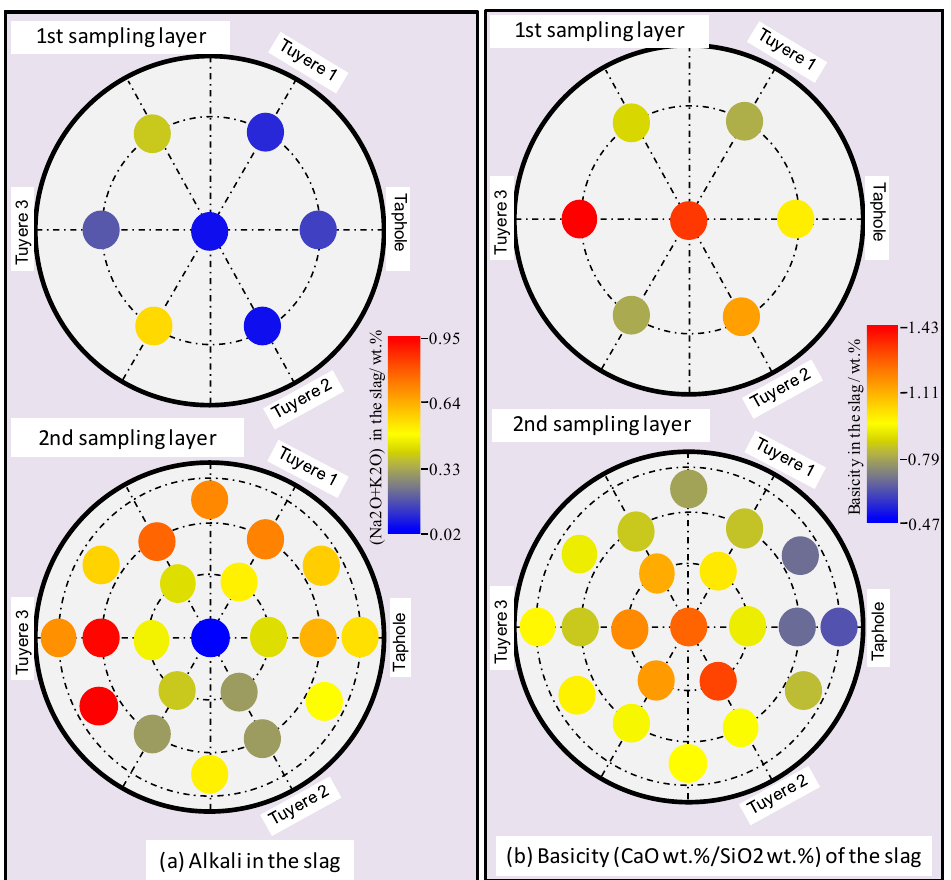
Figure 5. ( a ) Alkali contents in the slag samples and ( b ) basicity of the slag samples collected from the EBF hearth.